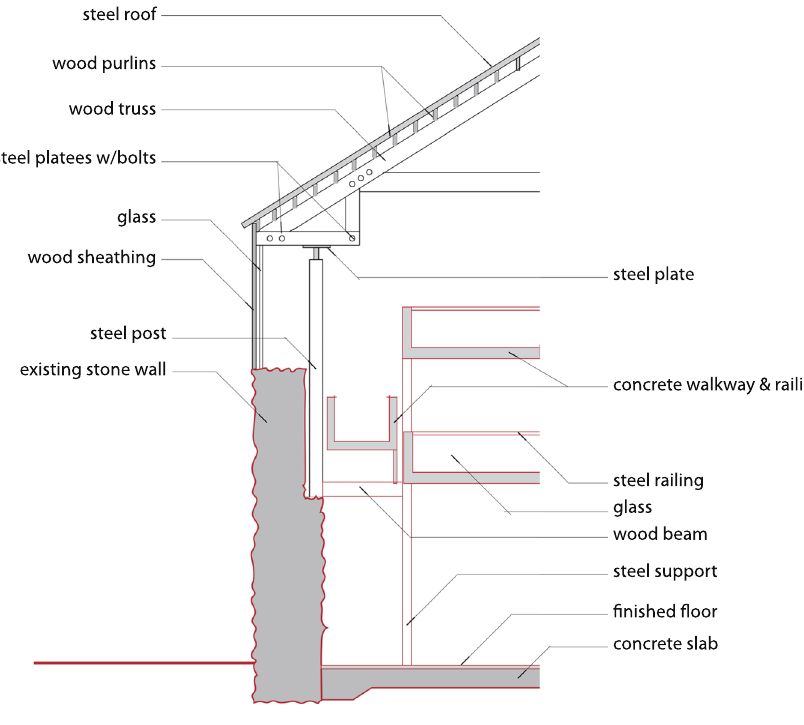
Fig. 10 Wall section detail of construction materials and connections of the Hedmark Museum (Source: the